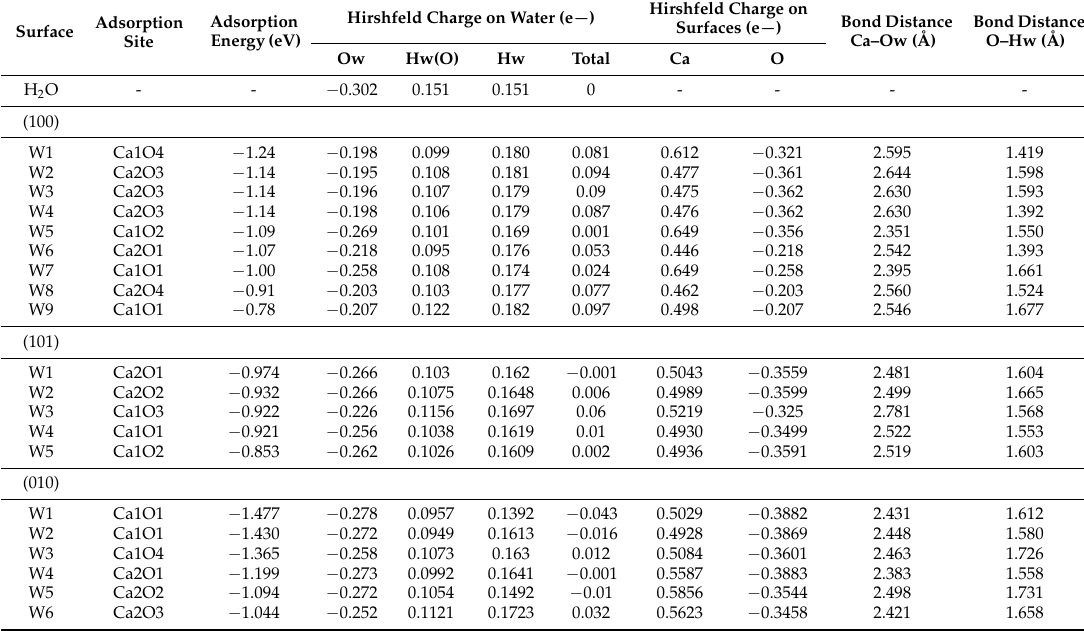
Table 2. The Hirshfeld charge of water molecule atoms for various adsorption sites as well as the corresponding adsorption energies. The adsorption sites are named in a descending adsorption energy order and the surface Ca and oxygen numbers are those in Figure 2. The water molecule atoms are named with the w subscript. The H w taking part of the hydrogen bond (see text) is labeled as H w